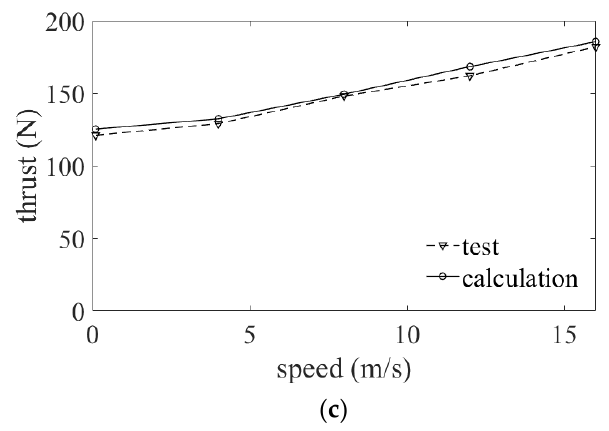
Figure 8. Comparisons between tests and calculations. ( a ) Required power of the isolated rotor. ( b ) Rotor thrust changes with velocity. ( c ) Percentages of wing’s download to rotor thrust.